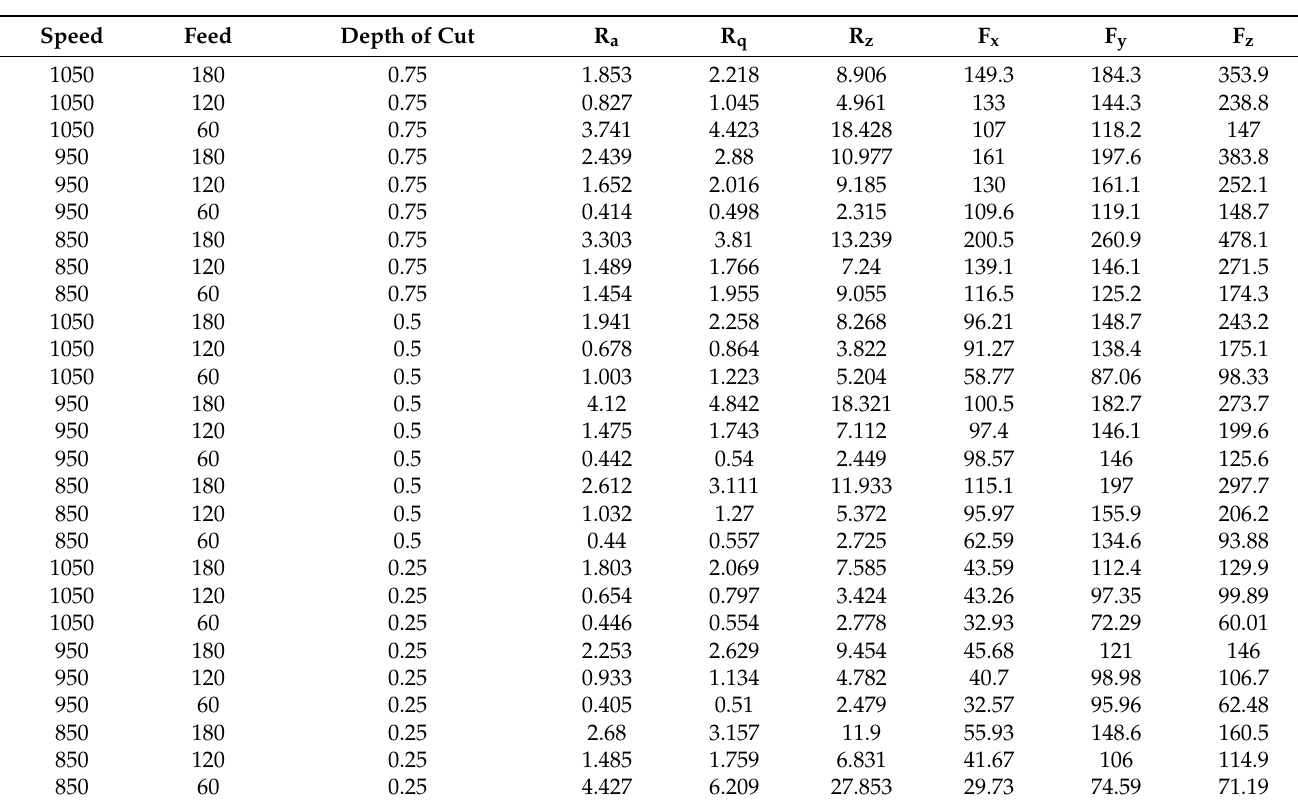
Table 2. Surface roughness and cutting force values when coated and cryogenic 36 h treated